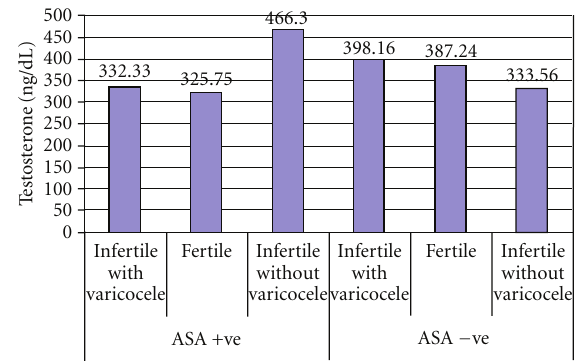
Figure 1: Testosterone levels in the serum of infertile and fertile men in relation to sperm